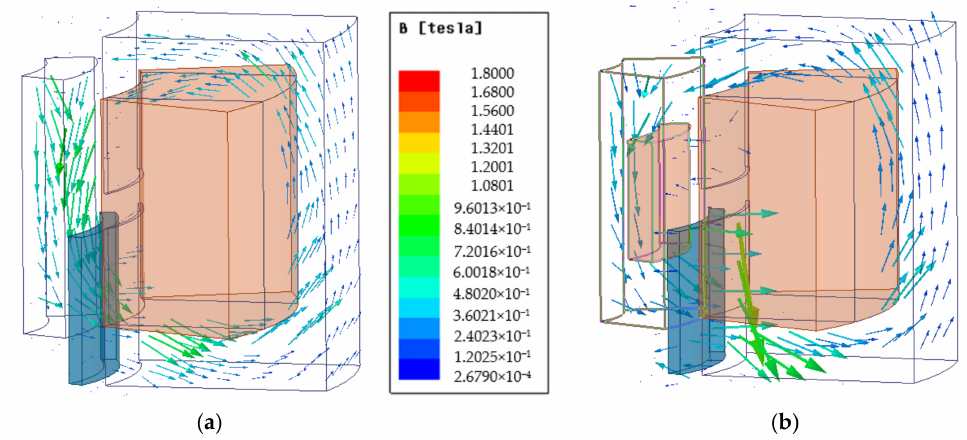
Figure 3. No-load flux density vector distributions: ( a ) Conventional model 1; ( b ) Proposed model